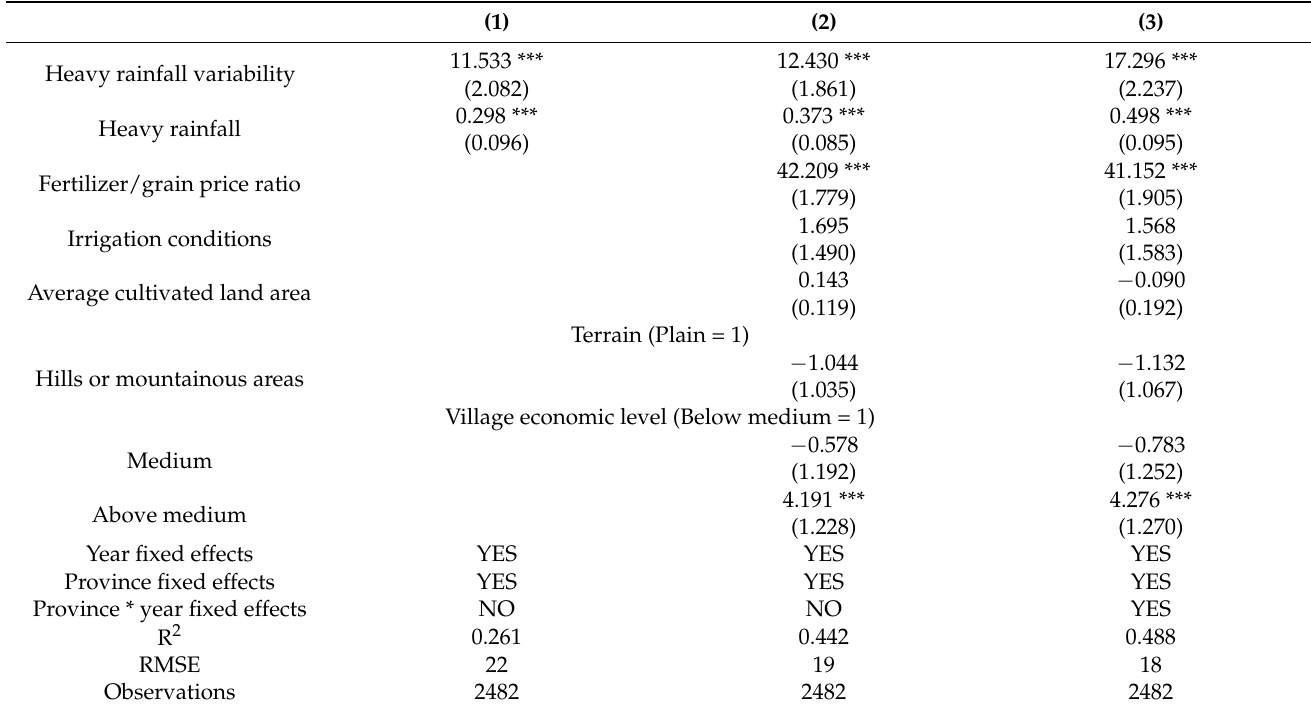
Table 3. Effect of heavy rainfall variability on fertilizer application